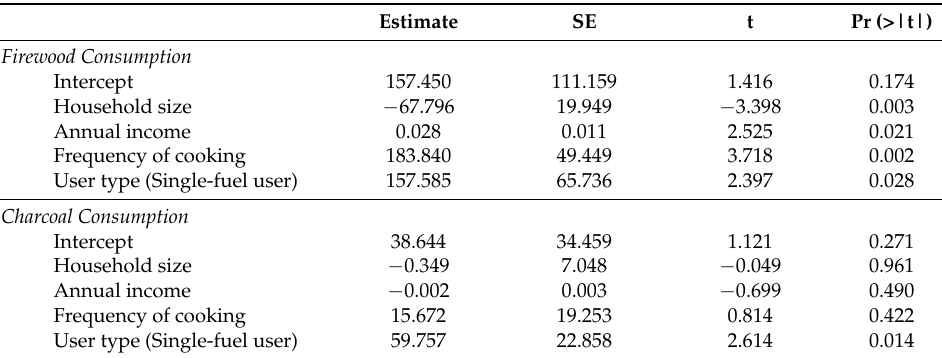
Table 4. The estimates of the generalized linear model